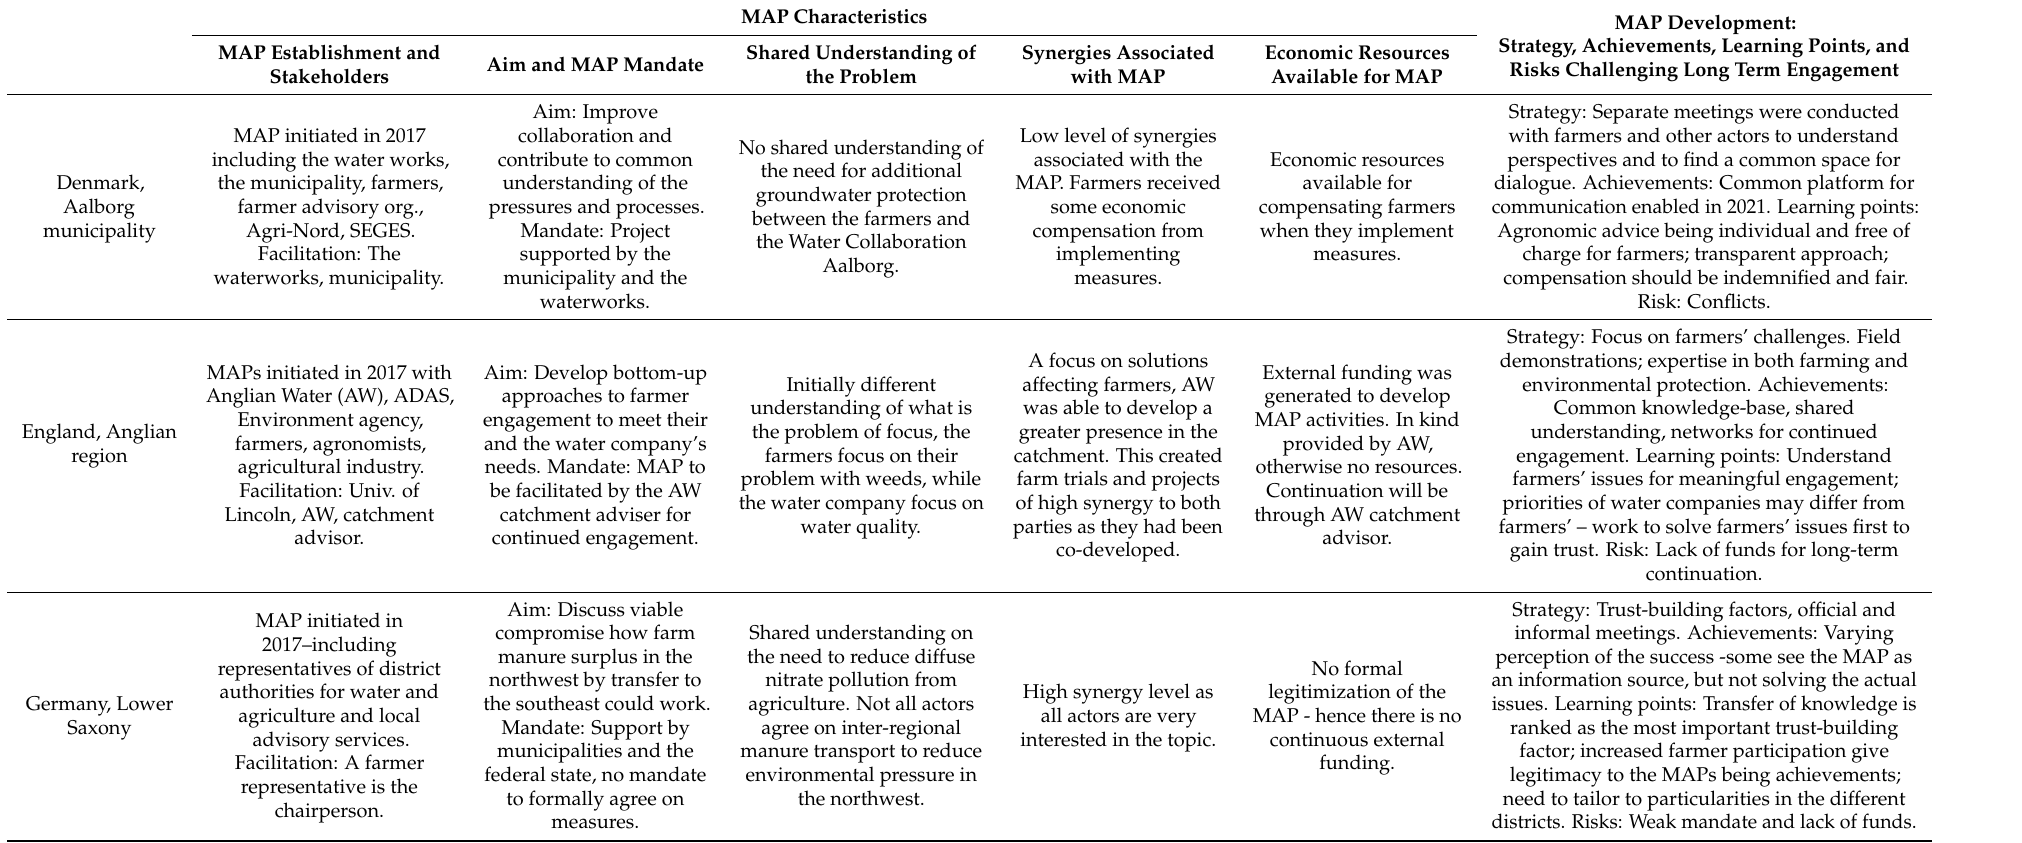
Table 2. MAP characteristics and developments Country, case